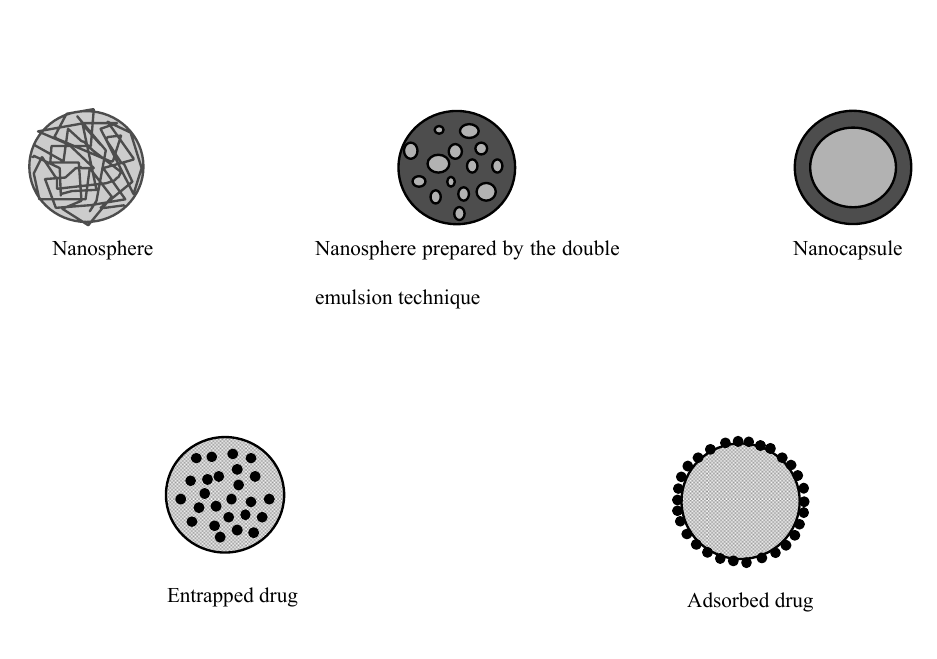
Figure 1 : Different types of polymeric particles